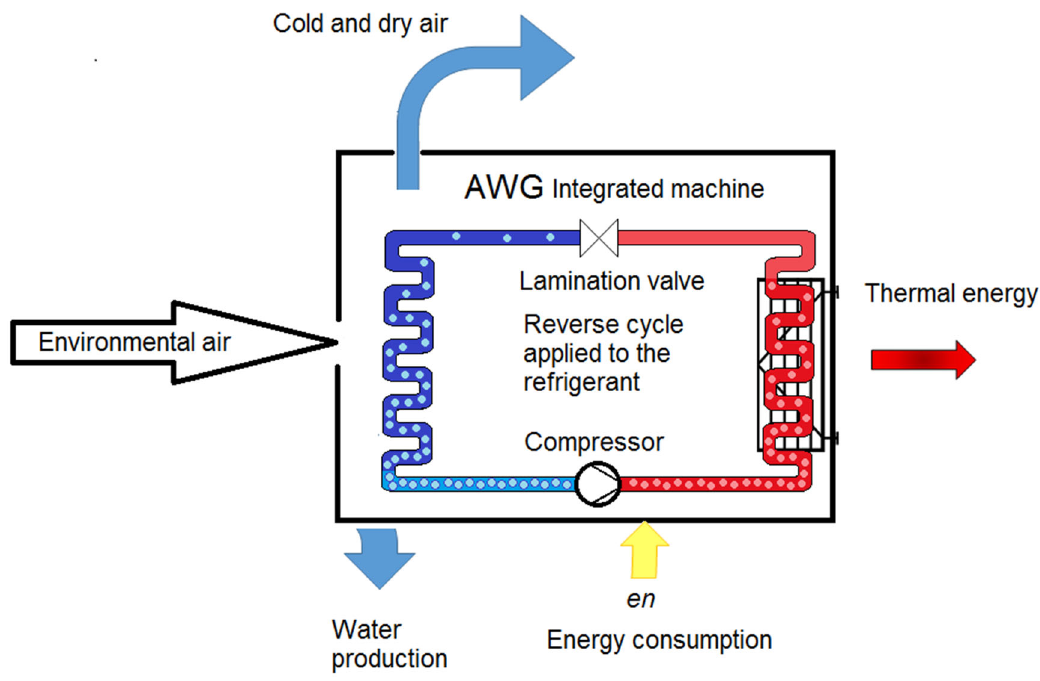
Figure 1. AWG integrated machine scheme.